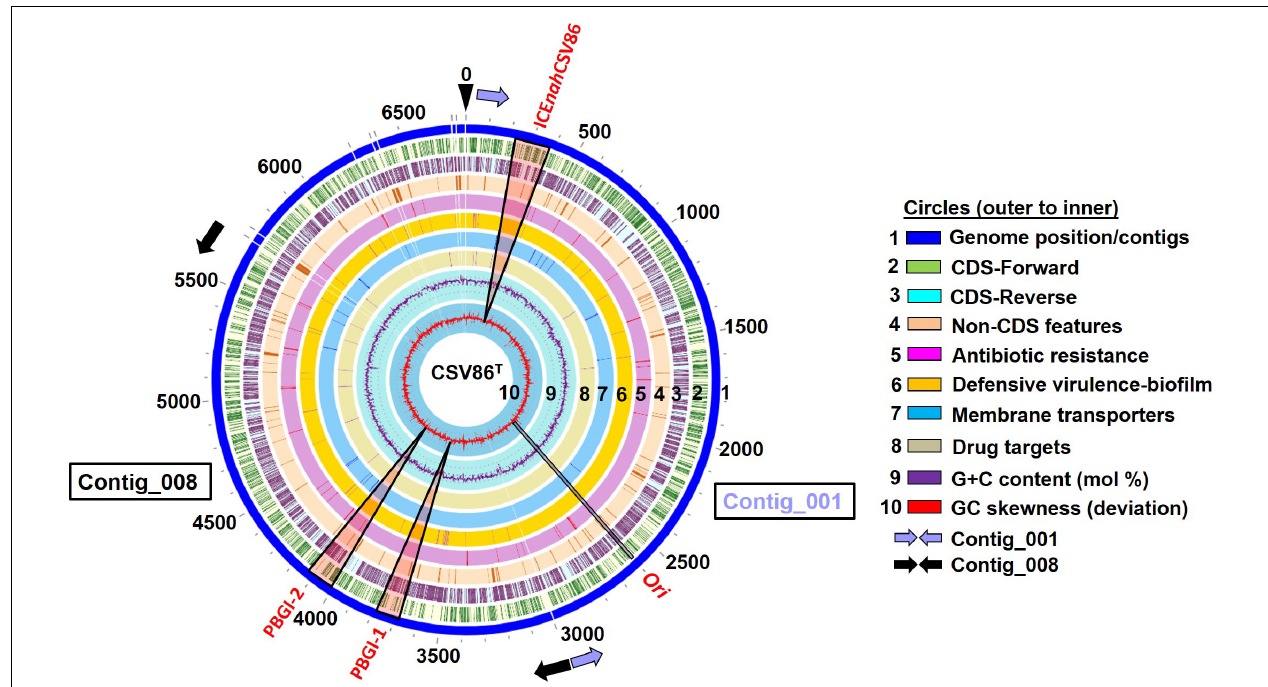
FIGURE 1 | Circular genomic map (0–6,975 Kb) depicting the location of three genomic islands (GIs), predicted to be integrative conjugative elements (ICEs: ICE nah CSV86, PBGI-1, and PBGI-2 in the genome of Pseudomonas bharatica CSV86 T along with various genomic attributes (GC mol%, skewness, CDS features). The genome map was reconstructed using PATRIC 3.7.2.2. Elongated triangular boxes (light red color) indicate the positions of three GIs on the genome. Ori , the origin of replication and replicative gene catamers are depicted by black rectangle. The start and the end positions of Contig_001 and Contig_008 are depicted by light blue and black filled arrows,